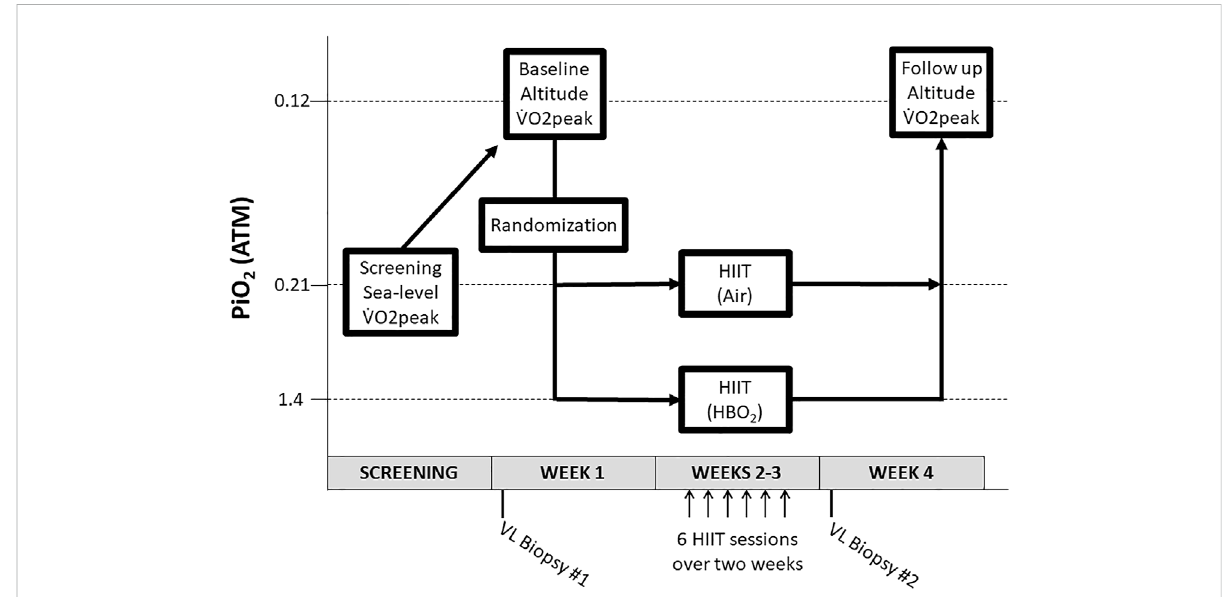
FIGURE 1 Study design. After a sea-level screening VO2peak test, subjects underwent a V _ O2peak test at altitude and were then randomized to HIIT + Air or HIIT + HBO